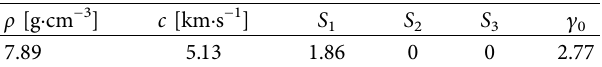
Table 3: Parameters of the Gruneisen equation of state for #45 steel.